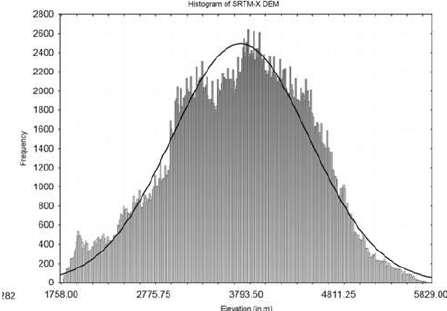
Figure 5: Histogram of SRTM X band DEM)